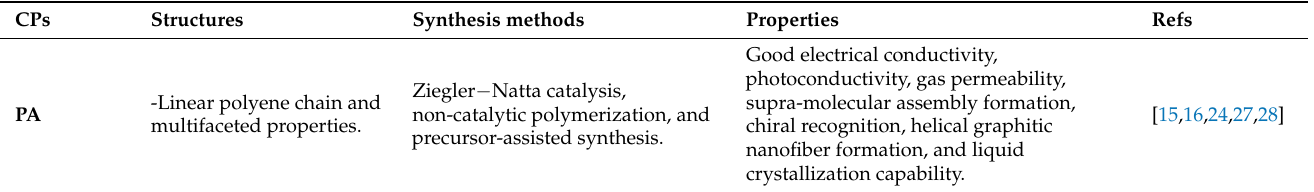
Table 1. Summarized structures, properties, synthesis methods, and applications of CPs for flexible